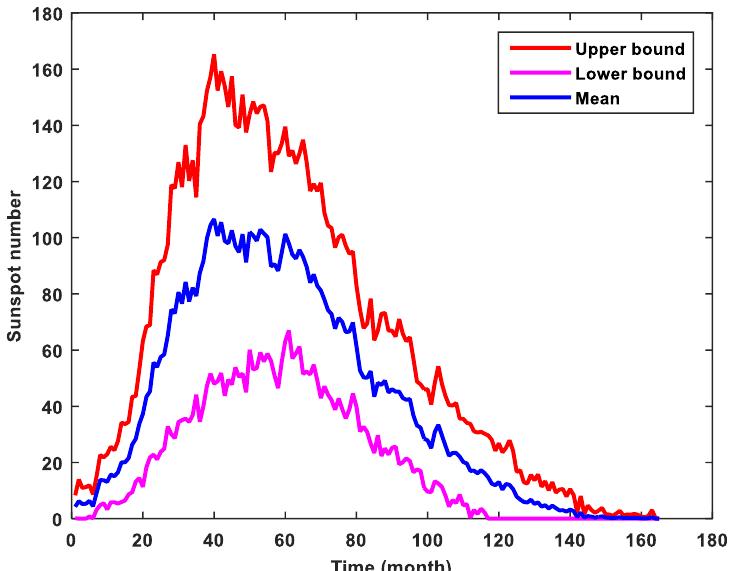
Figure-9. Mean cycle from the actual monthly sunspot cycle along with the mean+ s , the upper bound and mean- s , the lower bound profile Once we are having a prediction error and a prediction model, we can generate any number of forecast profile based on simple Monte Carlo method. Here we consider the envelop derived above as the envelope with 99.7% confidence or 3sigma confidence level, since all the realised cycles falls inside the proposed confidence interval band. Hence in the Monte Carlo simulation a typical profile will be generated using equation (29).